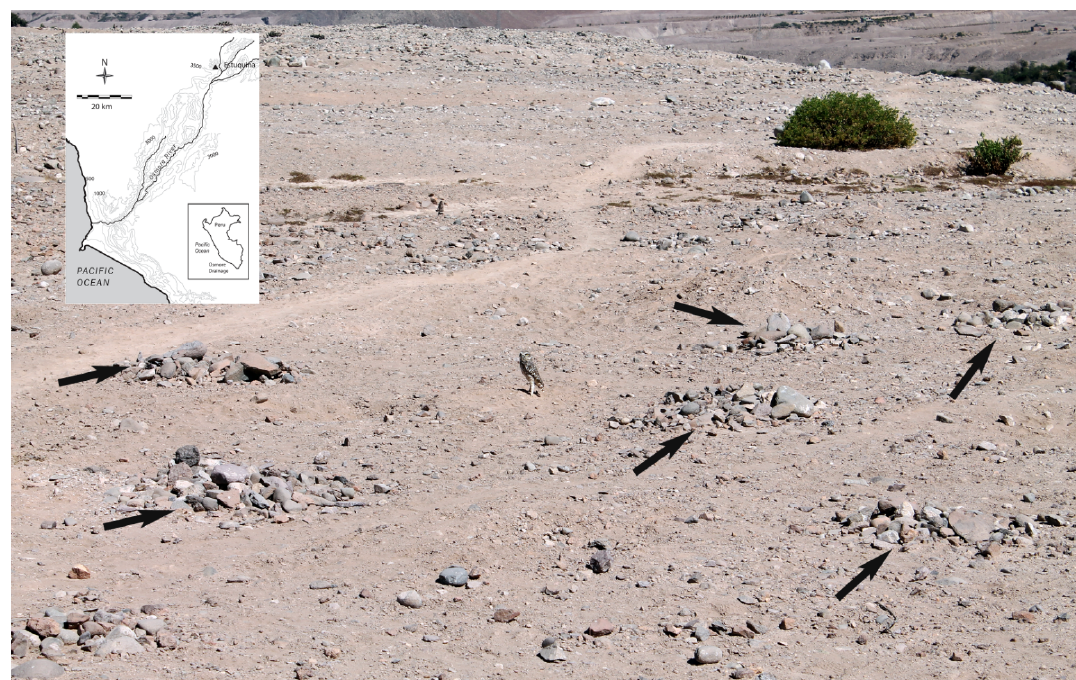
Figure 7. Burrowing Owl ( Athene cunicularia ) surrounded by seven (7) tombs at the site of Estuquiña (photo by Susan D. deFrance).